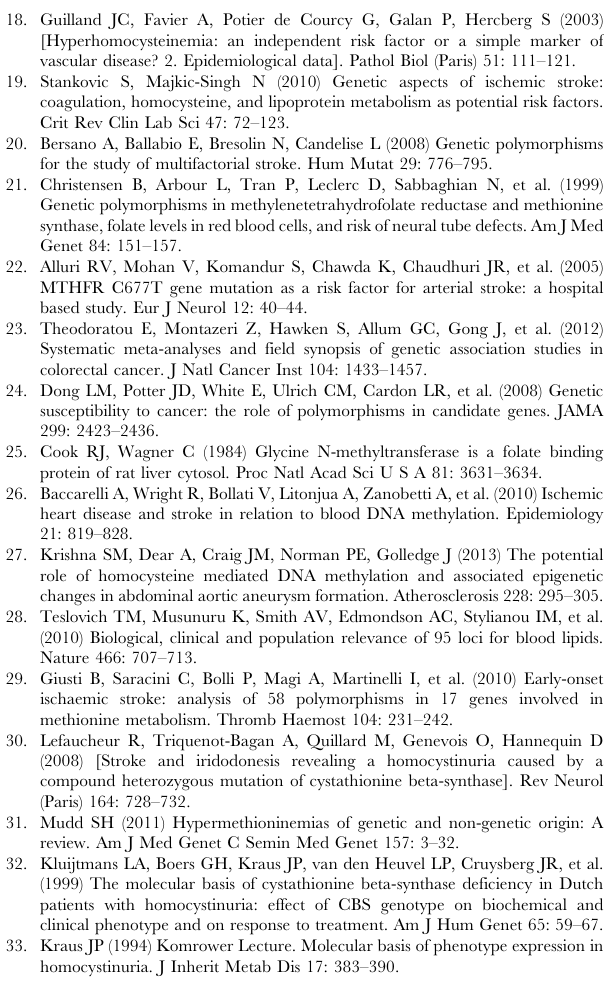
Figure S5 Genetic risk score in VISP using top genotyped SNPs. (A) Distribution of genetic risk scores in VISP. (B) Risk score vs. D POST in VISP. Error bars represent standard error. (PDF) Table S1 Independent GWAS results for D POST phenotype in VISP and FHS. Table S2 Correlation coefficients of principal components and D POST. As an exploratory analysis, we calculated the Pearson correlation coefficients of D Post with all the covariates (age, first 10 principal components from EIGENSTRAT analysis (FHS) or KING (VISP)) and corresponding p-values in FHS and VISP. Table S3 Test of heterogeneity for VISP-FHS meta-analysis of D POST. We use Cochrane’s Q statistic to test heterogeneity between FHS and VISP results. Cochrane’s Q statistic is the sum of squared deviations of each study’s effect estimate from the overall meta-analyzed effect estimate, weighted by inverse variance of the corresponding